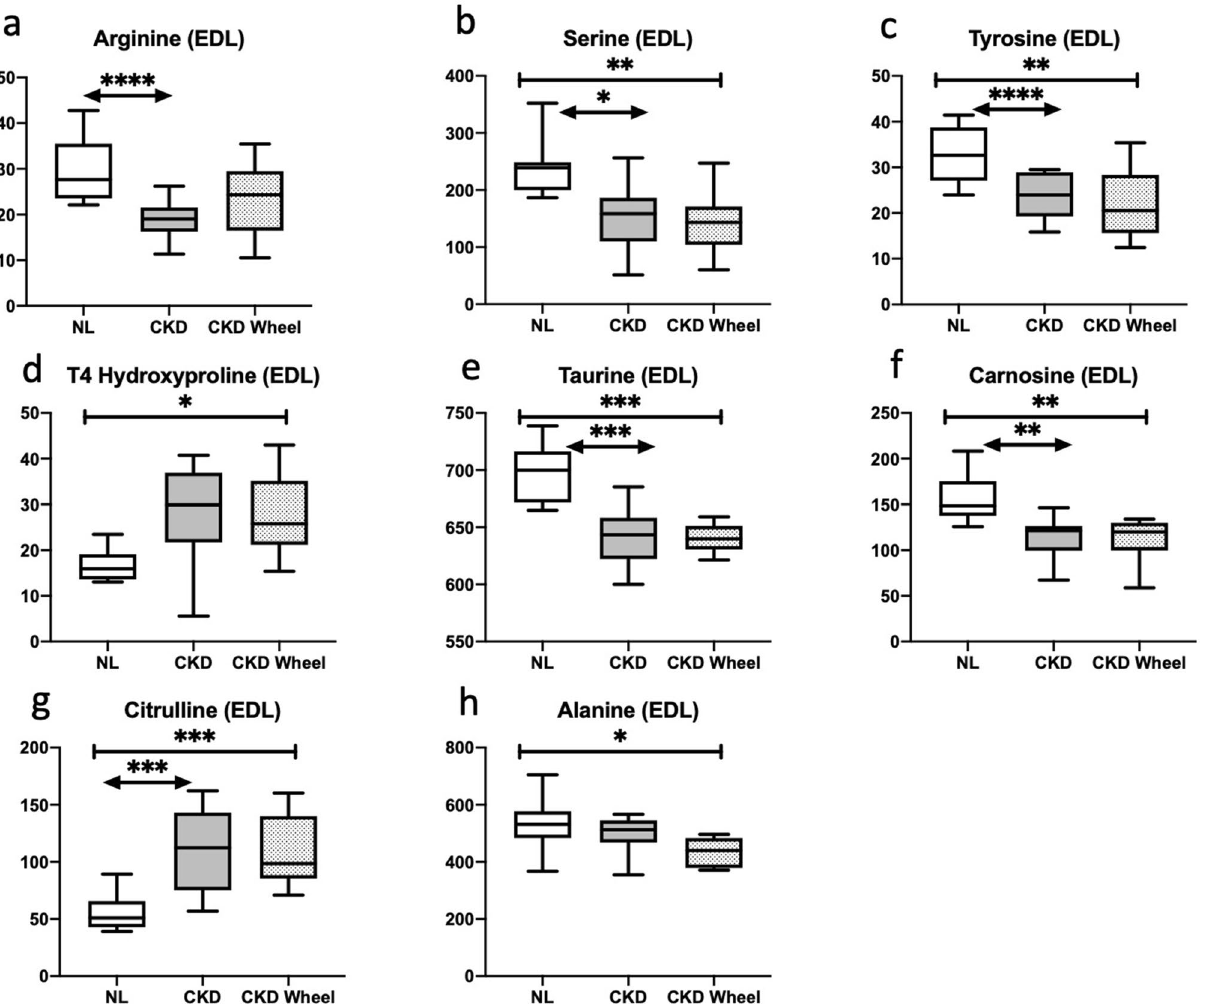
Figure 4. The EDL demonstrated differences in eight amino acid-related compounds. ( a – c ) In the EDL, arginine, serine and tyrosine were reduced in both the CKD and CKD-W with the exception of an arginine reduction in the CKD-W group ( p = 0.09). ( d ) 4-hydroxyproline was increased in the CKD-W group only, no difference between CKD and NL ( p = 0.056). ( e – g ) The potential markers of oxidative stress found in the soleus, including taurine, carnosine and citrulline have the same significant pattern in the EDL. (h) Alanine was reduced in the CKD-W rats compared to NL. Data are shown as mean ± SD (n = 9–12 rats each group). *P < 0.05, ** p < 0.01, *** p < 0.001. ⎴ (NL vs. CKD comparison); ← → (NL vs. CKD-W comparison); l—l (CKD vs. CKD-W